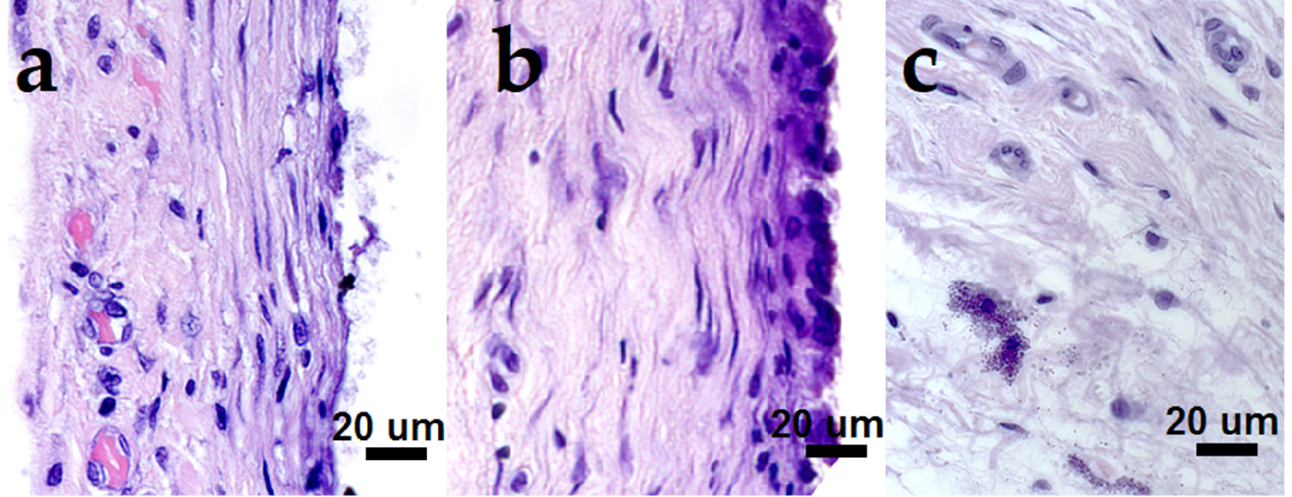
Figure 15. Features of the fibrous capsule cellular content surrounding the implanted materials, bar = 20 µm (( a )—capillaries, fibroblasts around Au/PtIr/CFR-PEEK, ( b )—fibrocytes in the hyper- chromic band and lymphocytic infiltration around CFR-PEEK, ( c )—mast cells in the outer capsule layer around Ag/Ir/CFR-PEEK).